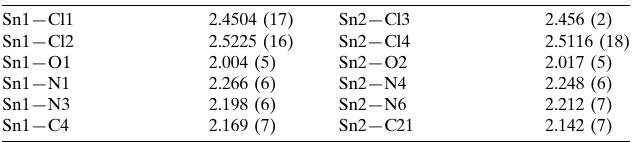
Selected bond lengths (A˚ ).